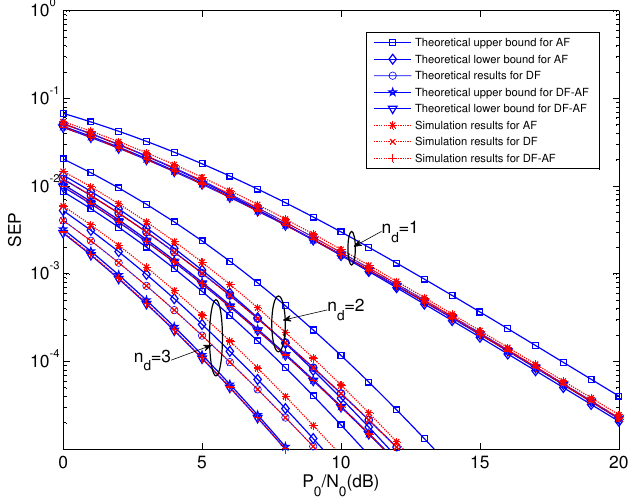
Figure 7. SEP performance of Alamouti code in Nakagami- m keyhole environments with fading parameters m 3 , m = 2 and all other fading parameters equal to g 22